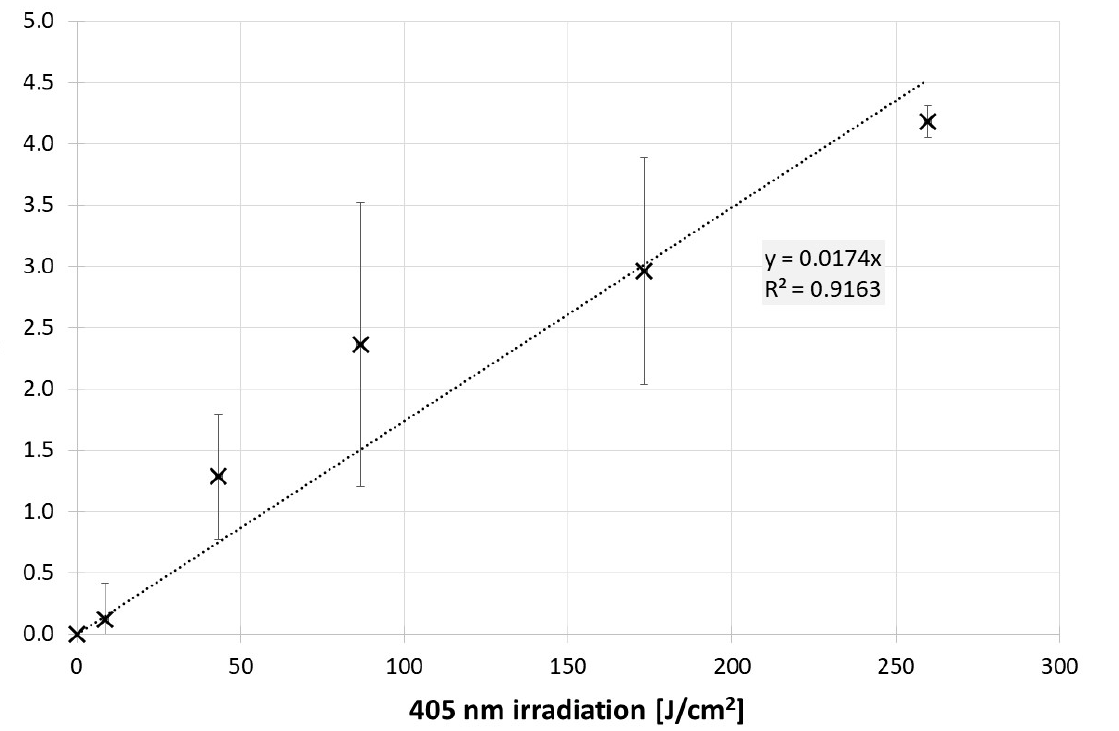
Figure 3. Log reduction of BCoV titer in PBS during 405 nm irradiation. The error bars represent the standard deviation of the individual measurements.